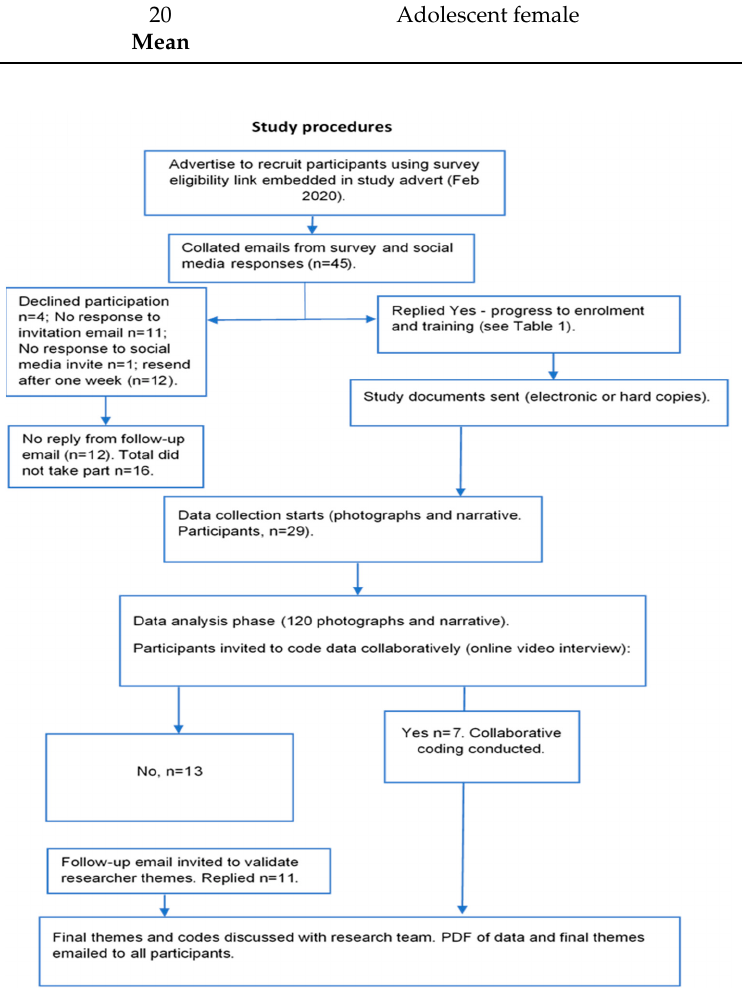
Figure 1. Flow chart showing study design; recruitment; collection and analysis phases.